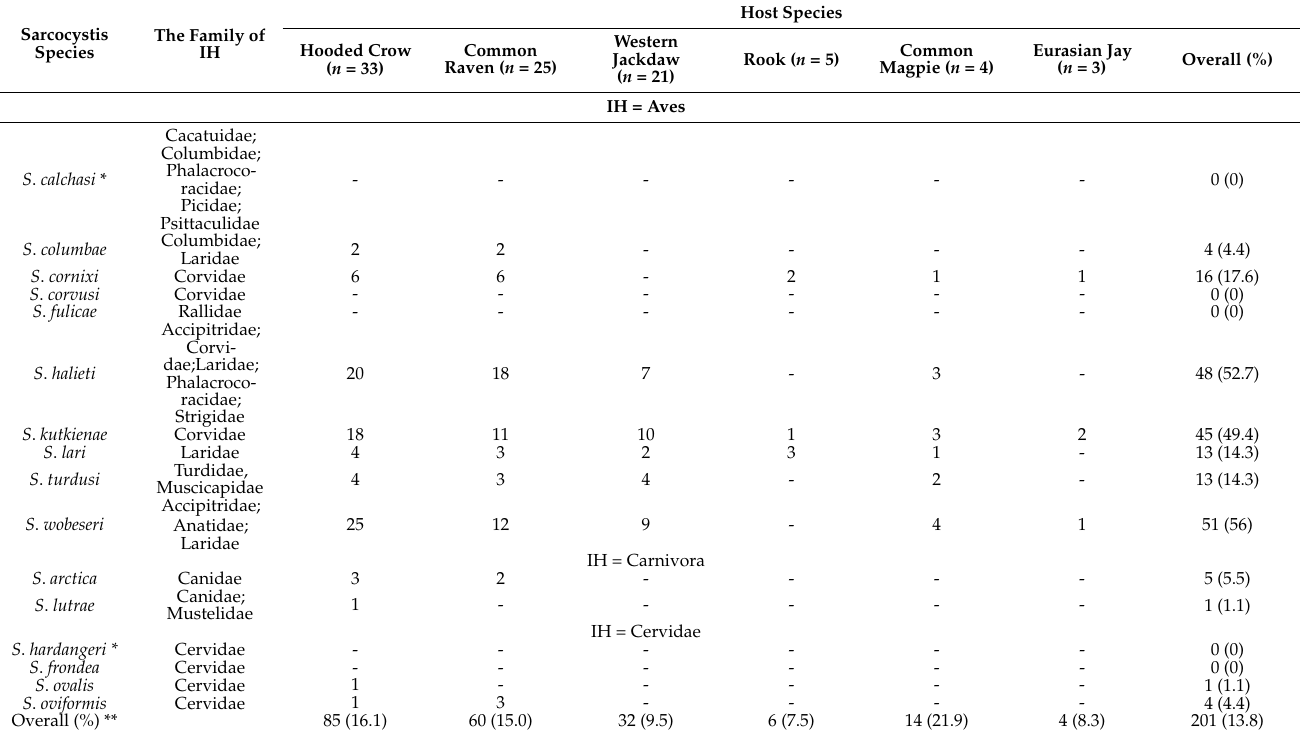
Table 4. Identification of Sarcocystis spp. in examined corvid samples from